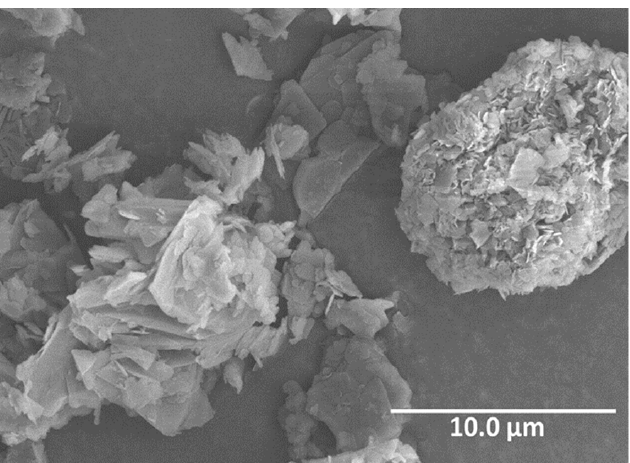
Figure 7. Scanning electron micrograph of commercially available, as received boron nitride mi- cronized platelets. Magnification, 4.50 kX, working distance (WD): 12.5 mm.